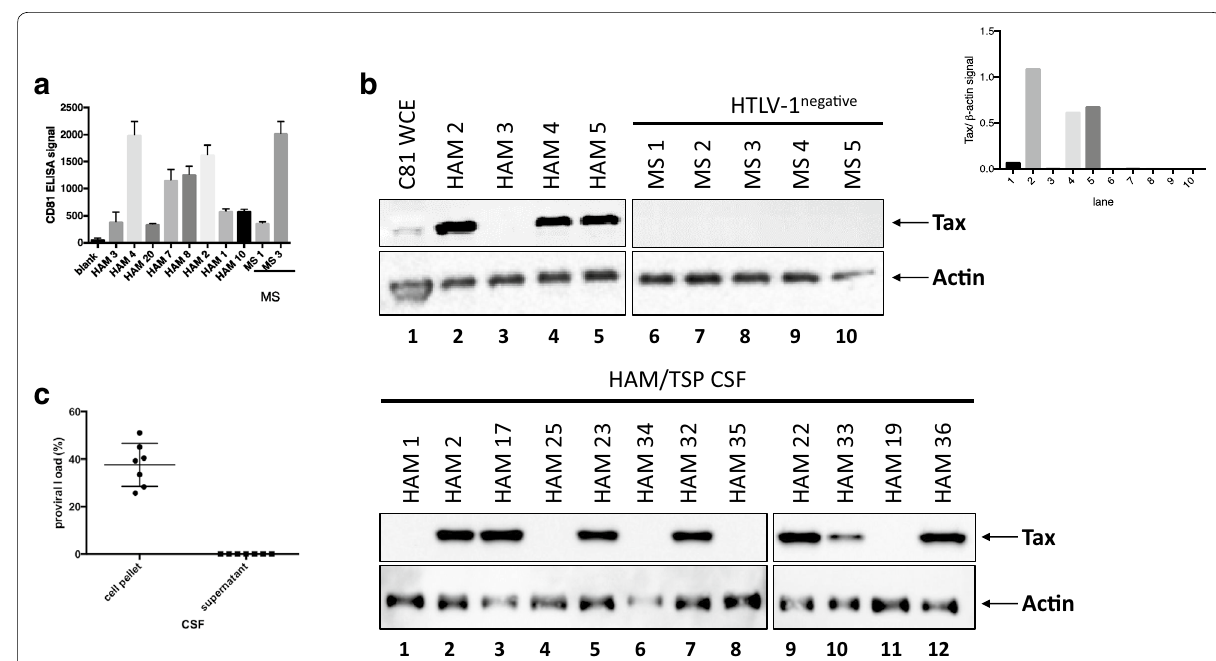
Fig. 5 Detection of exosomes containing HTLV‑1 Tax in CSF of HAM/TSP patients. a Cell‑free CSF samples from 8 HAM/TSP patients and 2 MS patients were nanotrapped (NT80 82) and analyzed by ELISA for CD81 signal to determine levels of isolated exosomes. b Four HAM/TSP (HAM) + and 5 multiple sclerosis (MS) patient CSF samples were nanotrapped (NT80 82), followed by Western blot analysis for Tax and Actin. C8166 + whole cell extract (C81 WCE, lane 1) was added as a positive control. Tax normalized to Actin (β‑actin) signal in the upper Western blot panel was quantified and is shown in the upper right inset. c Twelve HAM/TSP CSF samples were incubated with NT80 82 particles, followed by Western + blot analysis for Tax and Actin levels. d Presence of HTLV‑1 virus was assessed by analysis for the provirus. Pelleted cells and corresponding cell‑free supernatants from HAM/TSP CSF samples were probed for HTLV‑1 Tax by digital droplet PCR